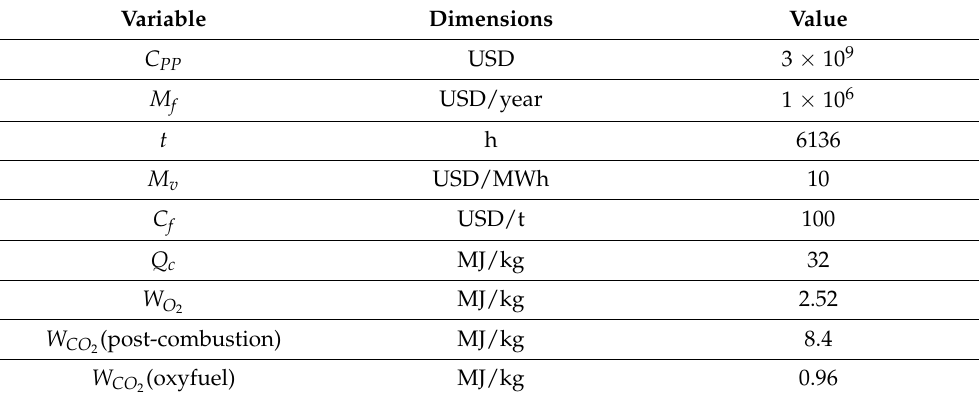
Table 2. Initial data for economic calculations (Data from